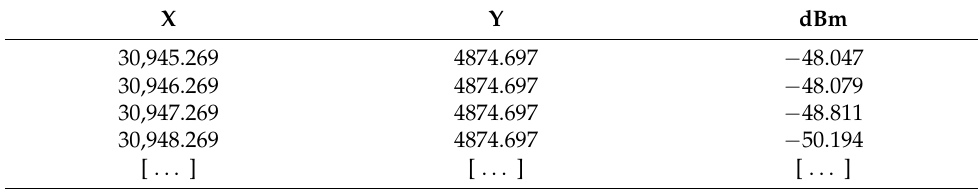
Table 6. Simulation values in